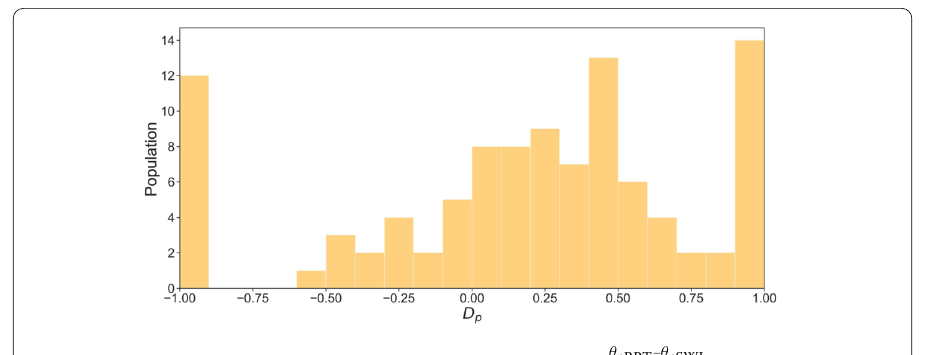
Figure 7 Balance between repeat and switch strategies. We define D p = that both strategies are used by players to the same extent. This plot shows that a significant number of players are using exclusively one of the strategies; other players use a combination of those with a bias towards repeating their previous guess, rather than